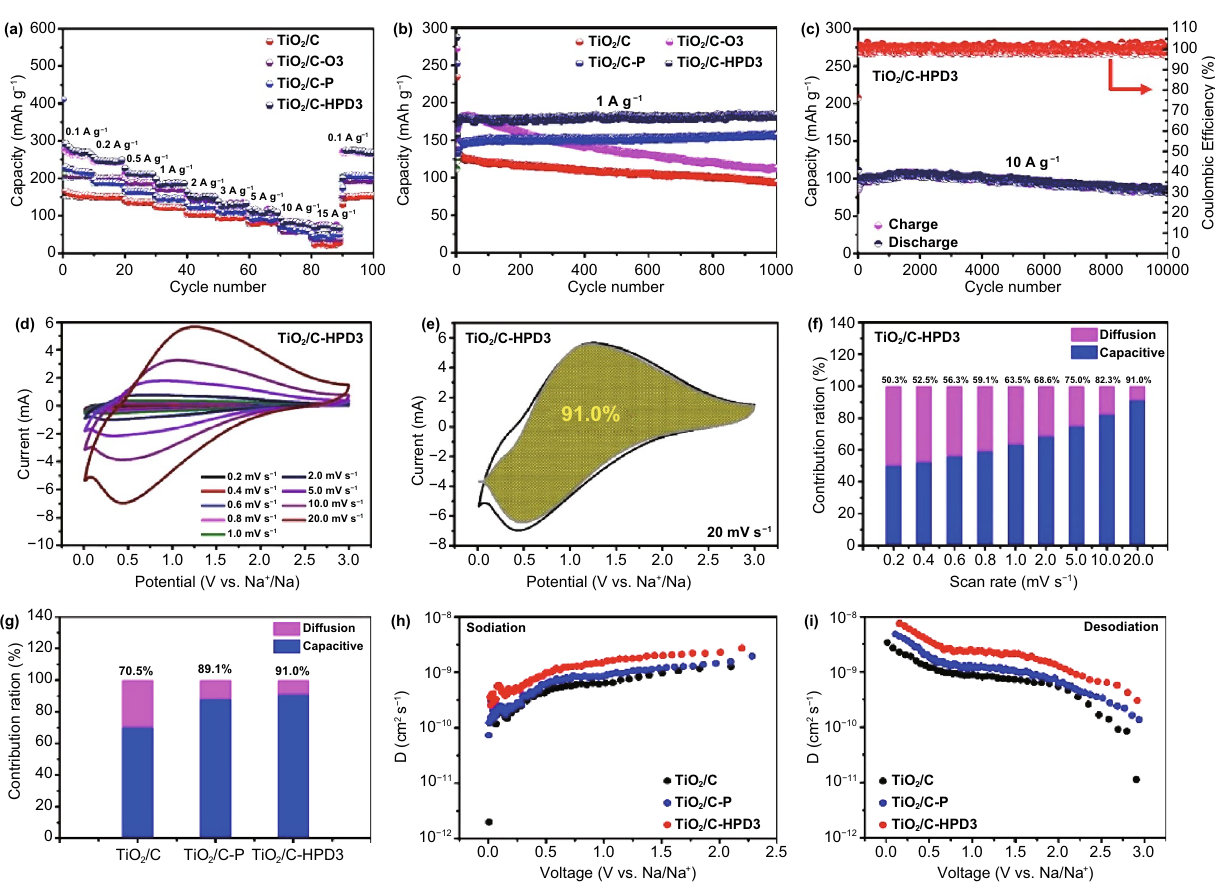
Fig. 5 TiO 2 /C, TiO 2 /C-O3, TiO 2 /C-P, and TiO 2 /C-HPD3: a Rate performances and b cycling performances at a current density of 1 A g −1 . TiO 2 /C-HPD3: c Long-term cycling performance at a current density of 10 A g −1 , d CV curves at various sweep rates, e CV curve with capacitive- and diffusion-controlled contributions at 20 mV s −1 and f Ratio of capacitive contribution at different scan. TiO 2 /C, TiO 2 /C-P and TiO 2 /C-HPD3: g Ratio of capacitive contribution at 20 mV s −1 , Diffusion coefficients calculated from the GITT potential profiles as a function of potential during h sodiation and i